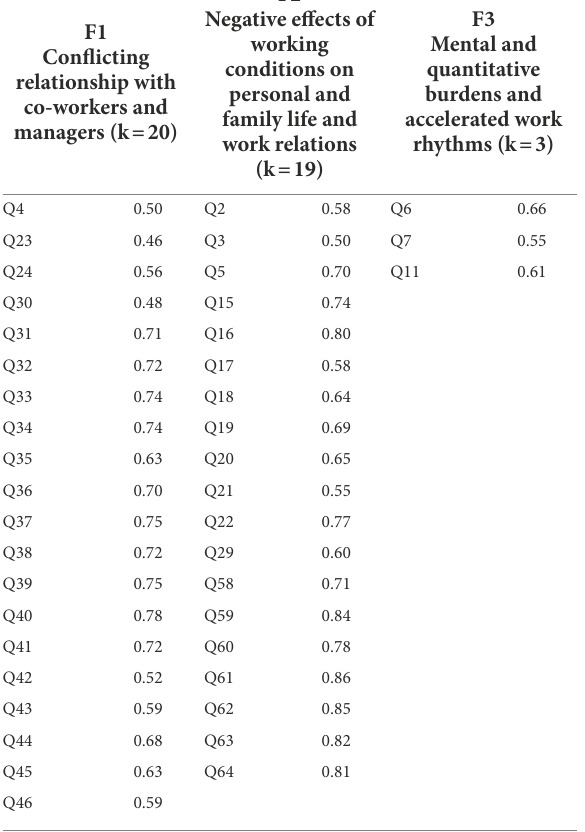
TABLE 6 Standardized factor loadings for the adjusted three-factor model (3-FM) of the IIA-PRF.